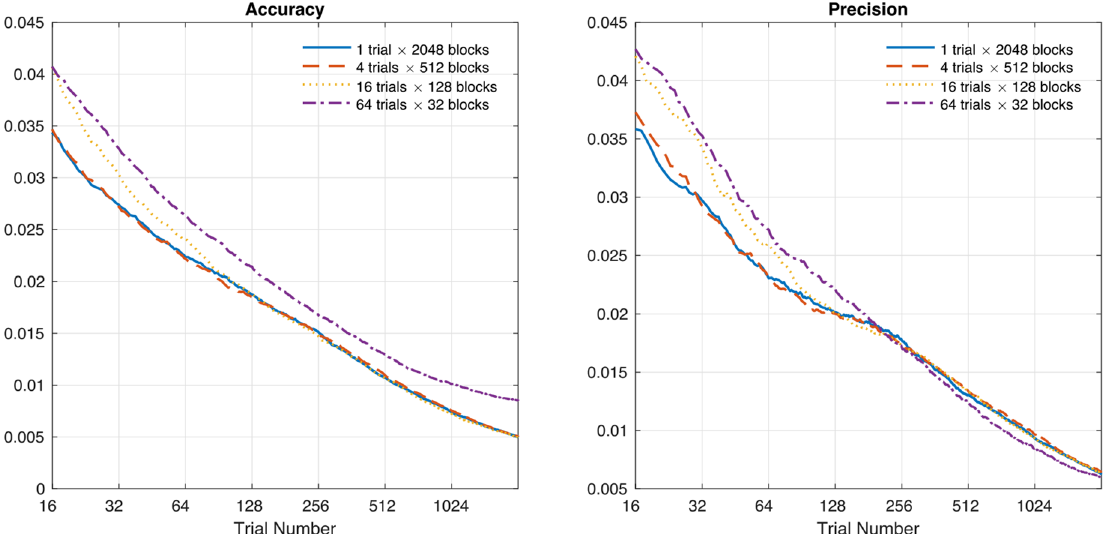
Figure 4. Accuracy and precision of SAT function estimated with Procedure 4 with different block lengths (1, 4, 16, and 64 trials in each block). The procedure with smaller block lengths (1 and 4) showed better accuracy and precision than with larger block lengths when a total number of trials was small (< 128 trials). The accuracy and precision with block length = 16 trials converged to those with smaller block lengths after 128